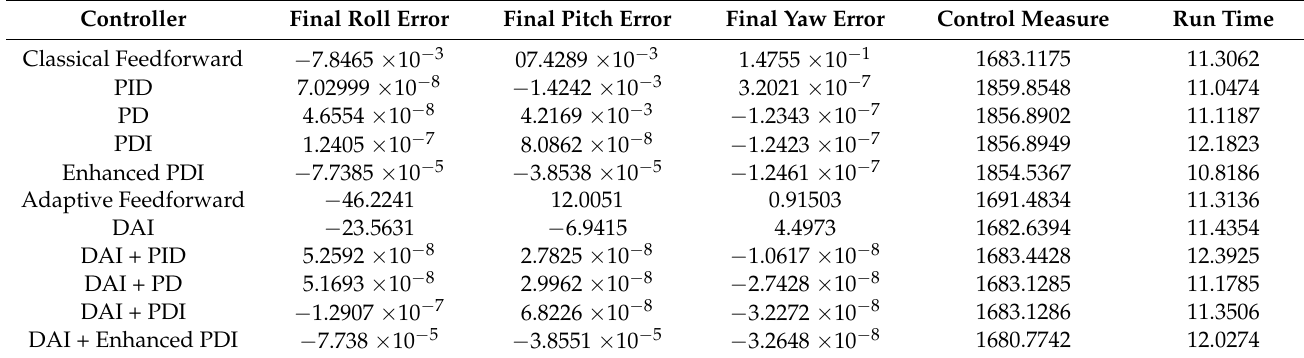
Table 3. System responses for various controller architectures in response to sinusoidal trajectory for a non-symmetric spacecraft.